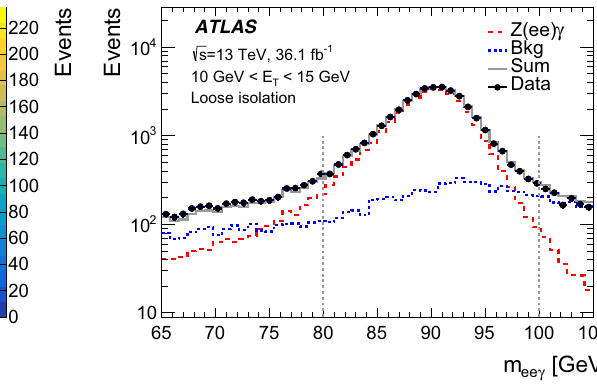
has 10 < E T < 15 GeV (black dots). The solid gray line represents the result of the fit to the data of the distribution to the sum of invariant mass templates for signal (dashed red line) and background (dotted blue line), both obtained from Sherpa MC simulation. The vertical dashed lines define the mass window used in the